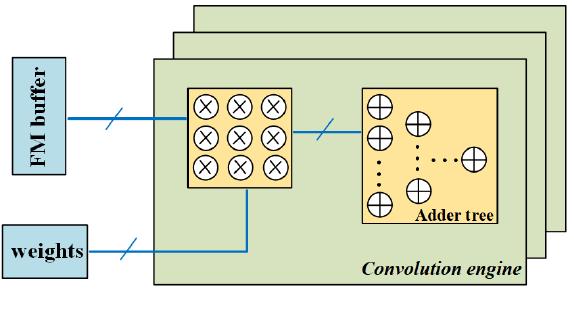
Figure 7. Hardware structure of the convolution